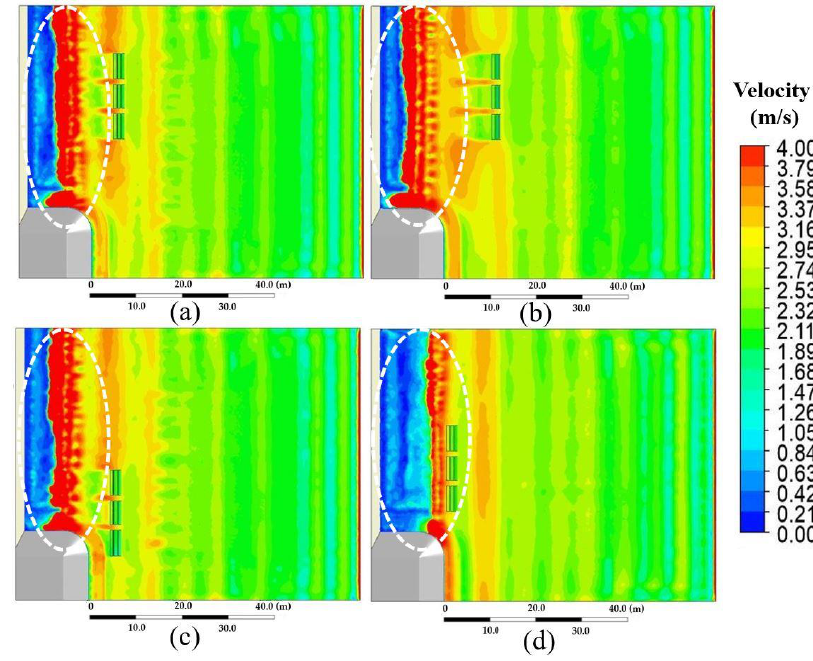
Figure 15. The water velocity of ( a ) P1/15 °, ( b ) P2/15° , ( c ) P3/15° , and ( d ) P4/15 °.